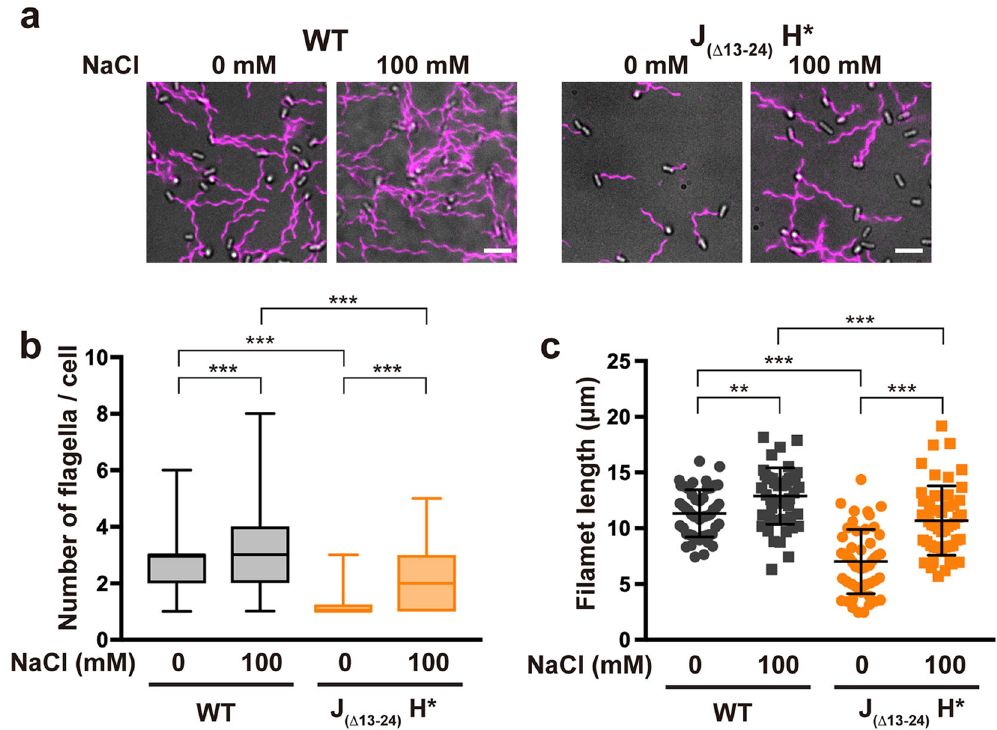
Fig. 2 Measurements of the number and length of fl agellar fi laments produced by the J ( Δ 13 – 24) H* strain. a Fluorescent images of the SJW1103 (WT) and MM104H-3 (J ( Δ 13 – 24) H * ) cells. The cells were grown in T-broth (pH 7.5) with or without 100 mM NaCl until the cells reached the stationary phase, and then fl agellar fi laments were labelled with a fl uorescent dye, Alexa Fluor 594. The fl uorescence images of the fi laments labelled with Alexa Fluor 594 (magenta) were merged with the bright fi eld images of the cell bodies. Scale bar, 5.0 μ m. b Average number of fl agellar fi laments. Box plots show the number of the fl agellar fi laments in the WT and J ( Δ 13 – 24) H * cells. Lower and upper box boundaries are 25th and 75th percentiles, respectively. The line in the middle of the box is median. Lower and upper error lines are the smallest and largest values, respectively. More than 110 cells were counted. c Scatter plots of fl agellar fi lament length. Filament length is the average of 50 fi laments, and vertical lines are standard deviations. Comparisons between datasets were performed using a two-tailed Student ’ s t -test. A P -value of <0.05 was considered to be statistically signi fi cant difference. ** P < 0.01; ** *P < 0.001. (Also see Supplementary Table